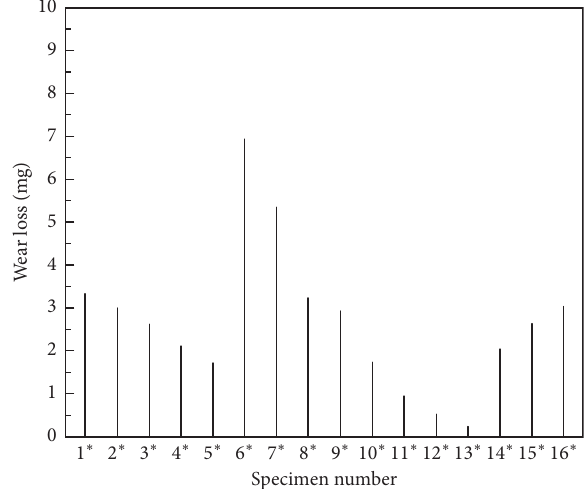
Figure 6: Wear loss graph by thin film deposition